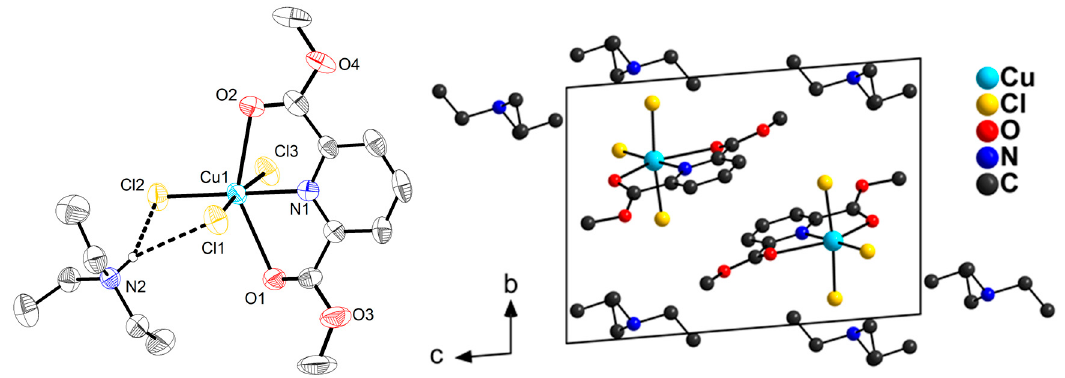
Figure 3. ORTEP representation (50% probability level) of the molecular structure of (HNEt 3 )[Cu(pydicMe 2 )Cl 3 ]. H atoms are omitted for clarity. Right: Crystal structure of (HNEt 3 )[Cu(pydicMe 2 )Cl 3 ] along the crystallographic a -axis. Comparison of (HNEt 3 )[Cu(pydicMe 2 )Cl 3 ] with the reported complex [Cu(pydicMe 2 )(H 2 O) 3 ](ClO 4 ) 2 [17] reveals the same bond parameters within the pydicMe 2 ligand, similar Cu-ligand distances in the equatorial plane: Cu–N 1.990(3) Å, Cu ‒ OH 2 1.992(3), 1.949(3), and 2.000(3) Å, respectively, and long Cu–O keto bonds of 2.332(3) and 2.338(3) Å. Thus, both Cl – in [Cu(pydicMe 2 )Cl 3 ] and H 2 O in [Cu(pydicMe 2 )(H 2 O) 3 ] represent stronger ligands than the carbonyl ester O atoms.